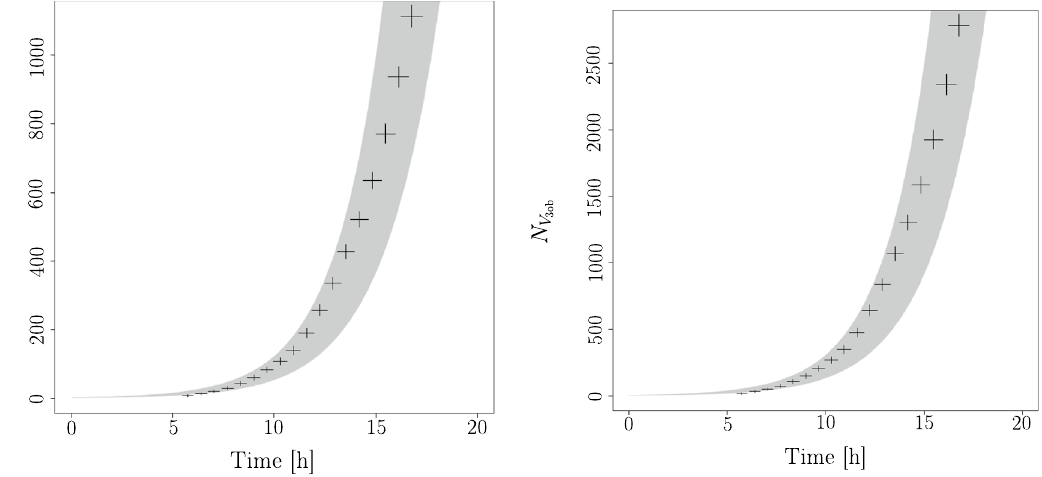
Figure 7. Left, one-standard deviation range of the experimental data fit of V 1 ob (grey) versus time, points: number of V 1 ob coming from the simulation (black) with scaled time. Right, one-standard deviation range of the experimental data fit of V 3 ob (grey) versus time, points: number of V 3 ob coming from simulation (black) with scaled time to the data obtained from V 1 ob . See text for